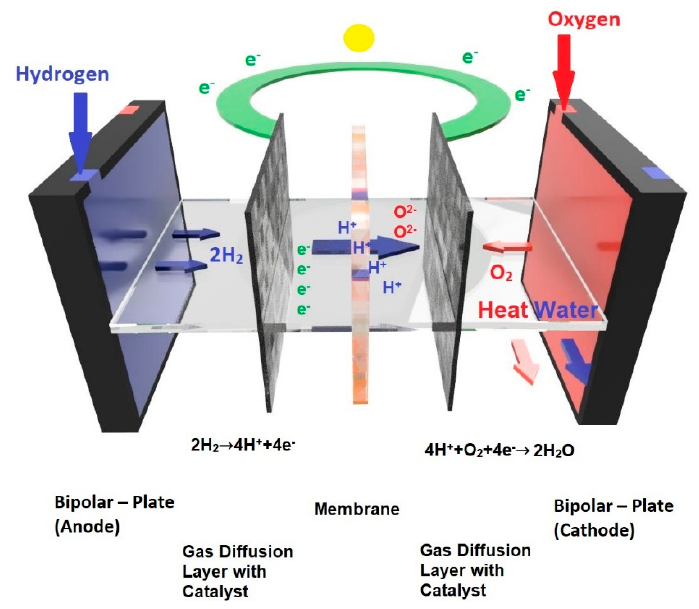
Figure 1. Proton exchange membrane fuel cell model.